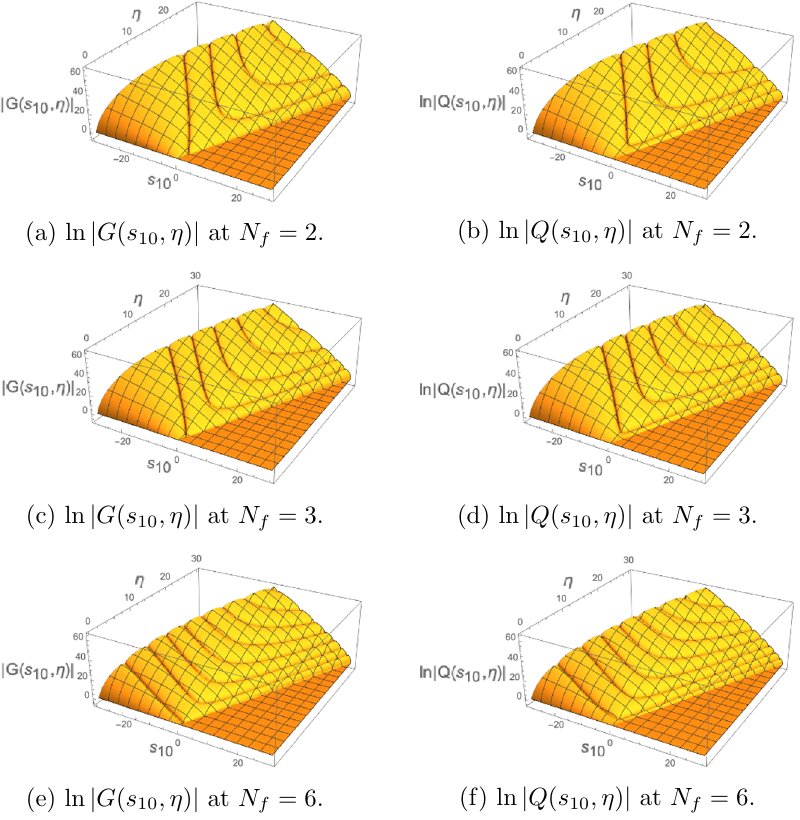
Figure 2 . Plots of ln j G ( s 10 ; (cid:17) ) j and ln j Q ( s 10 ; (cid:17) ) j for N f = 2 ; 3 ; 6 and N c = 3. All the graphs result from numerical computations with the step size (cid:1) (cid:17) = 0 : 075 and (cid:17) max =